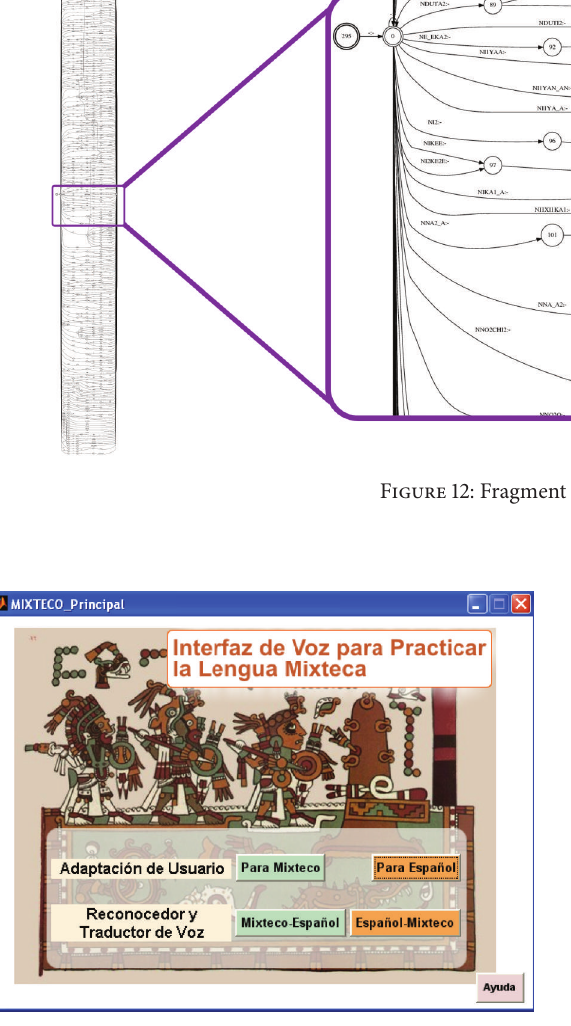
Figure 13: Main window of the speech interface with the Mixtec ASR